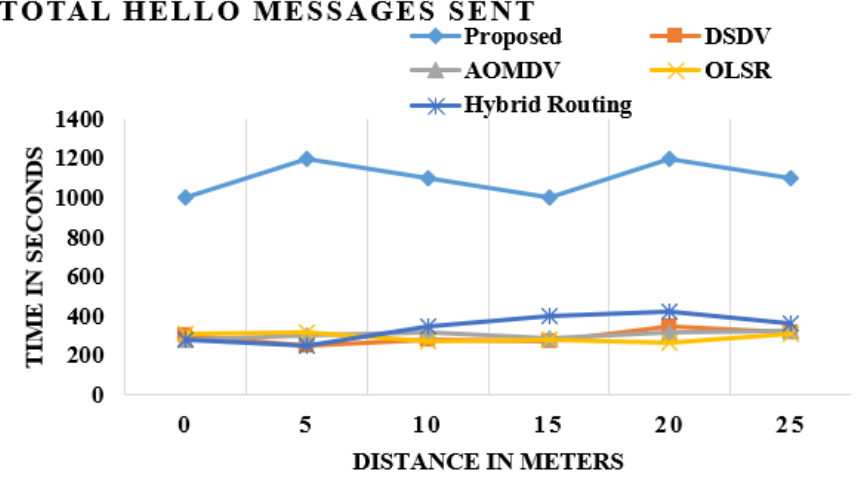
Figure 6. Comparison of hello message